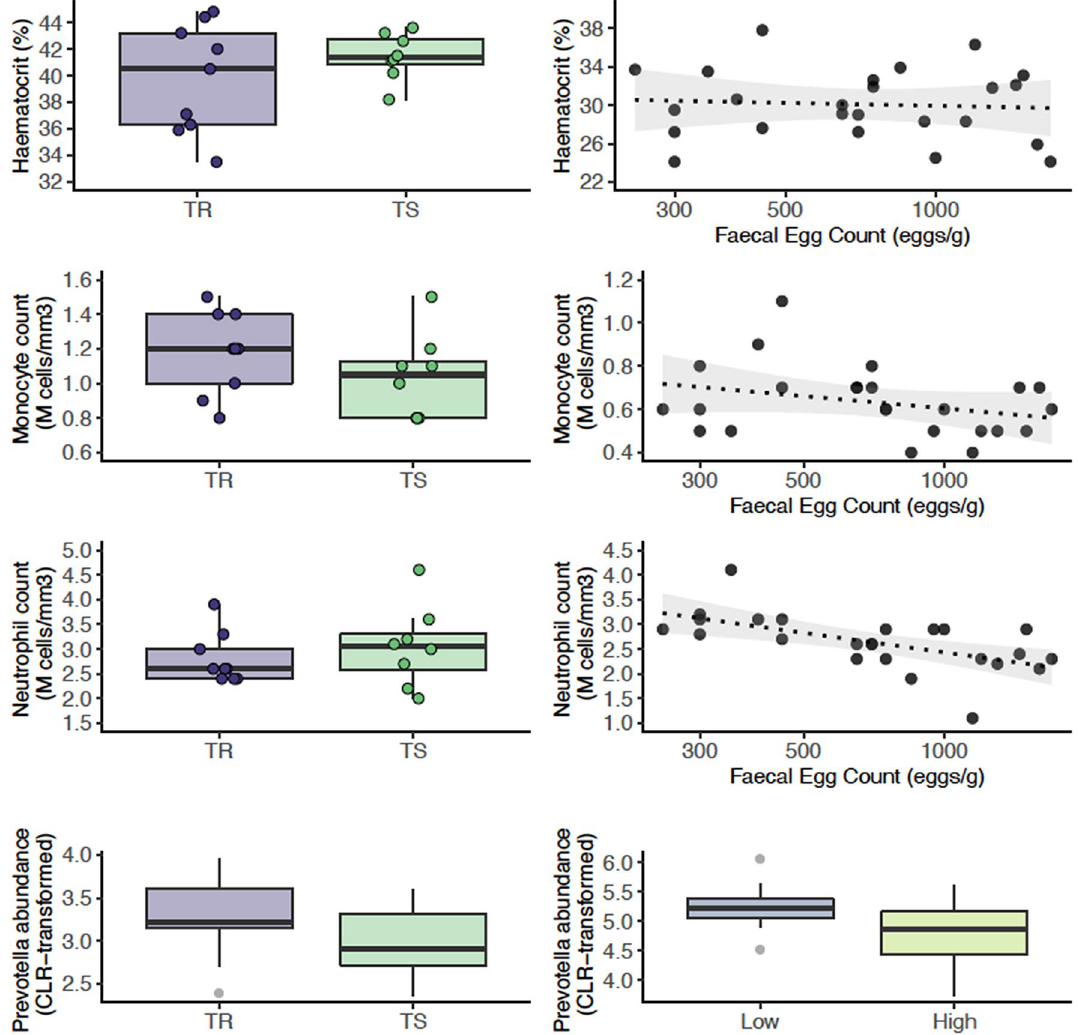
Figure 5. Validation of the most discriminant features between resistant and susceptible ponies under strongylid infection. Each row presents the feature level in resistant and susceptible ponies (left panels) and the association with faecal egg count recorded in an independent set of ponies or horses (for the Prevotella genus). CLR centered log-transformed. The figure highlights the significant positive relationship between circulating monocyte count and faecal abundance of the Prevotella genus in independent